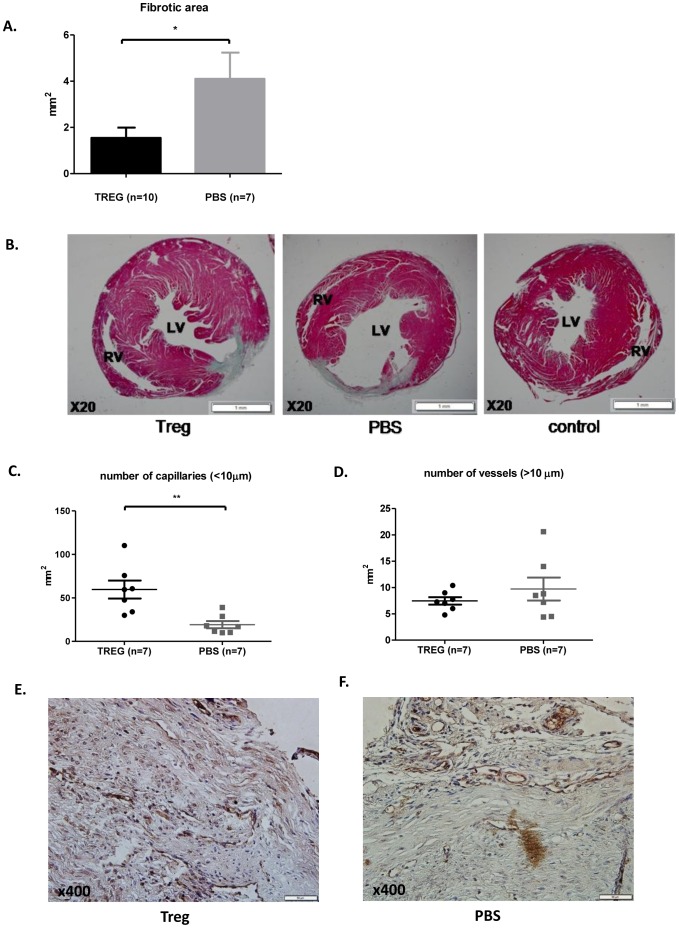
Adoptive transfer of regulatory T cells reduces infarct size.(A) Morphometry shows that treatment with Tregs reduces the proportion of fibrosis. (B) Representative sections of mouse heart treated with Tregs or PBS and labeled by Masson Trichrome staining at x20 magnification compared to control heat. (C) The number of capillaries was 2-fold greater in the Treg-treated group. (D) The number of vessels>10 µm was similar between the groups. (E–F) Serial sections were immunolabeled with antibodies against CD31 at x400 magnification. *p<0.02, **p<0.002 based on Mann-Whitney test.